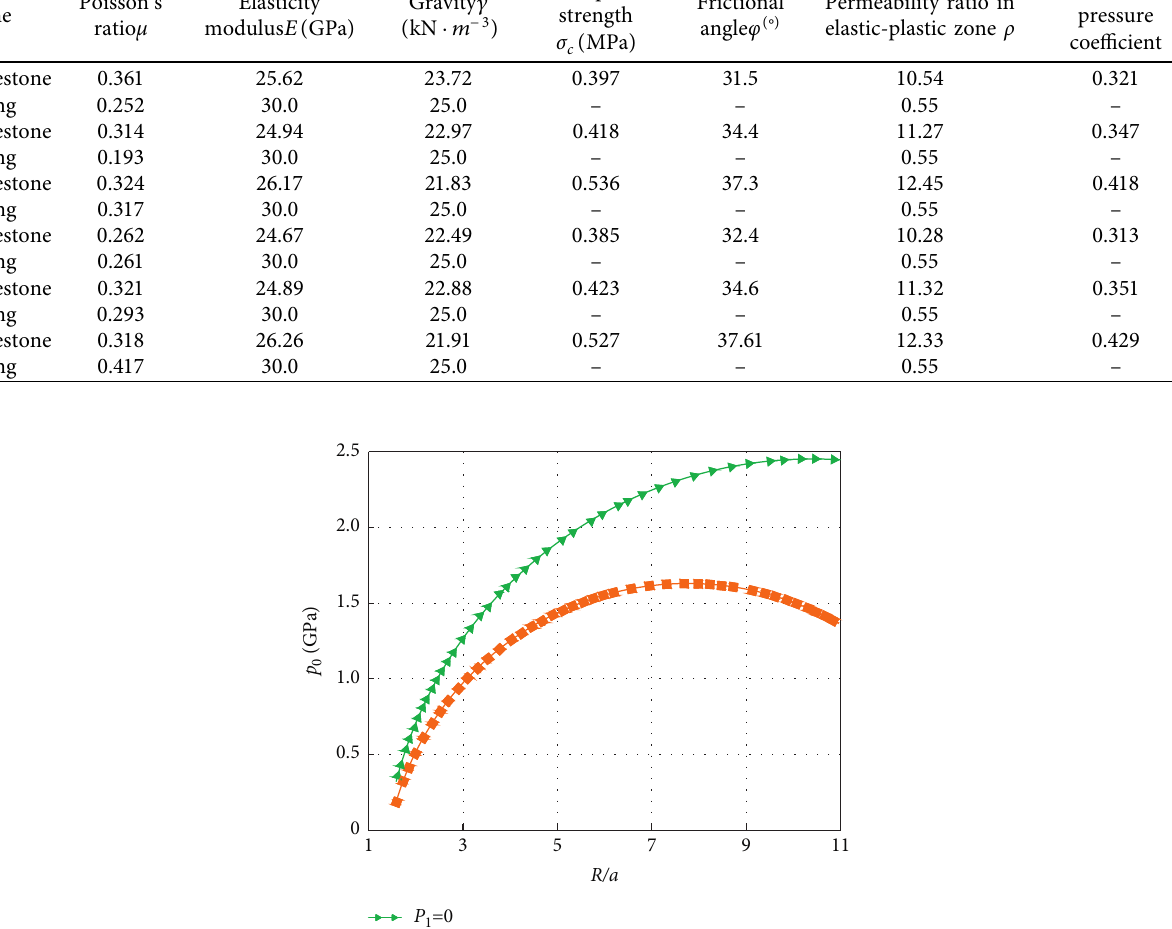
and R / a of the plastic region. 0